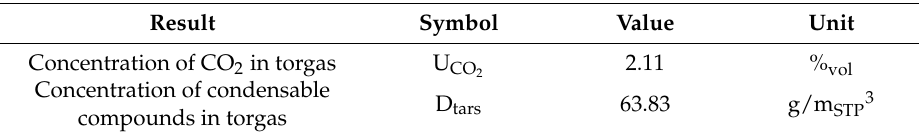
Table 5. Composition of torgas—major constituents.